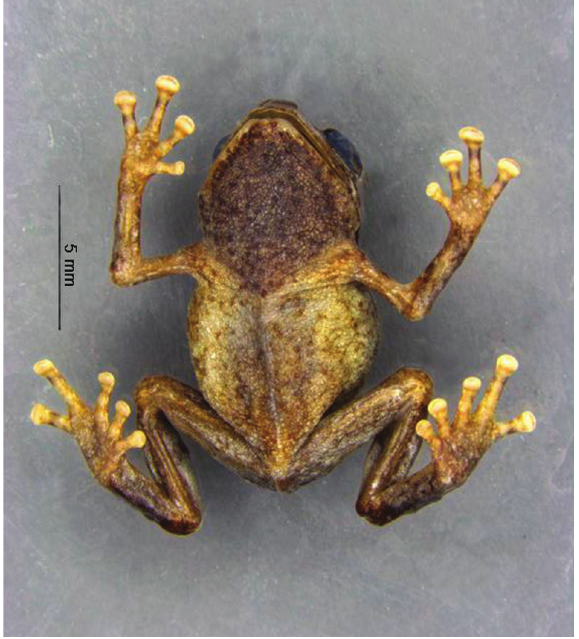
Figure 11b. Preserved holotype of Choerophryne bisyllaba sp. n. in ventral